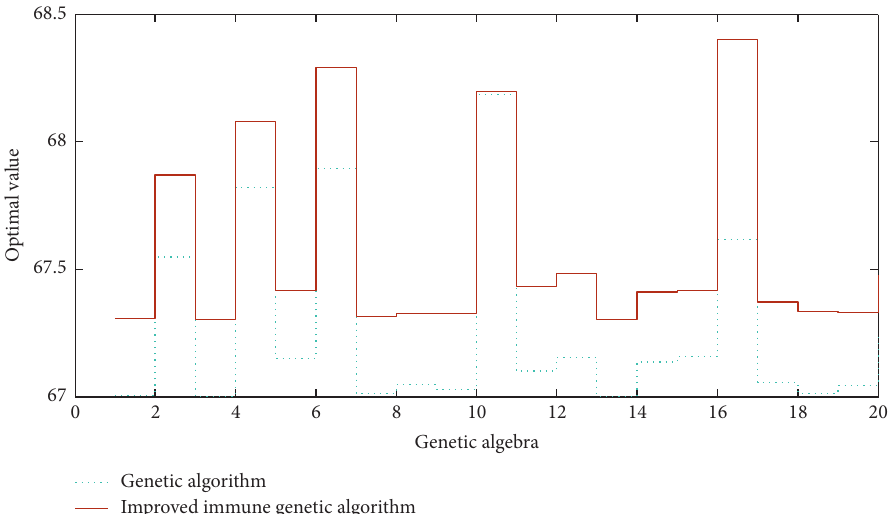
Figure 9: Cluster prediction solution simulation diagram of genetic algorithm and improved immune genetic algorithm. 6868.56969.57070.5